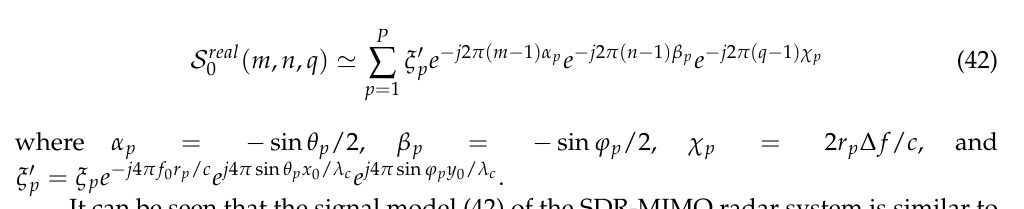
where ϕ p and θ p denote the angles of the p -th target, x p = r p sin θ p , y p = r p sin ϕ p , and (cid:113) + y 2 + z 2 r p = x 2 . With similar approximations as those used to get (11), we can get the p p p following 3D signal model